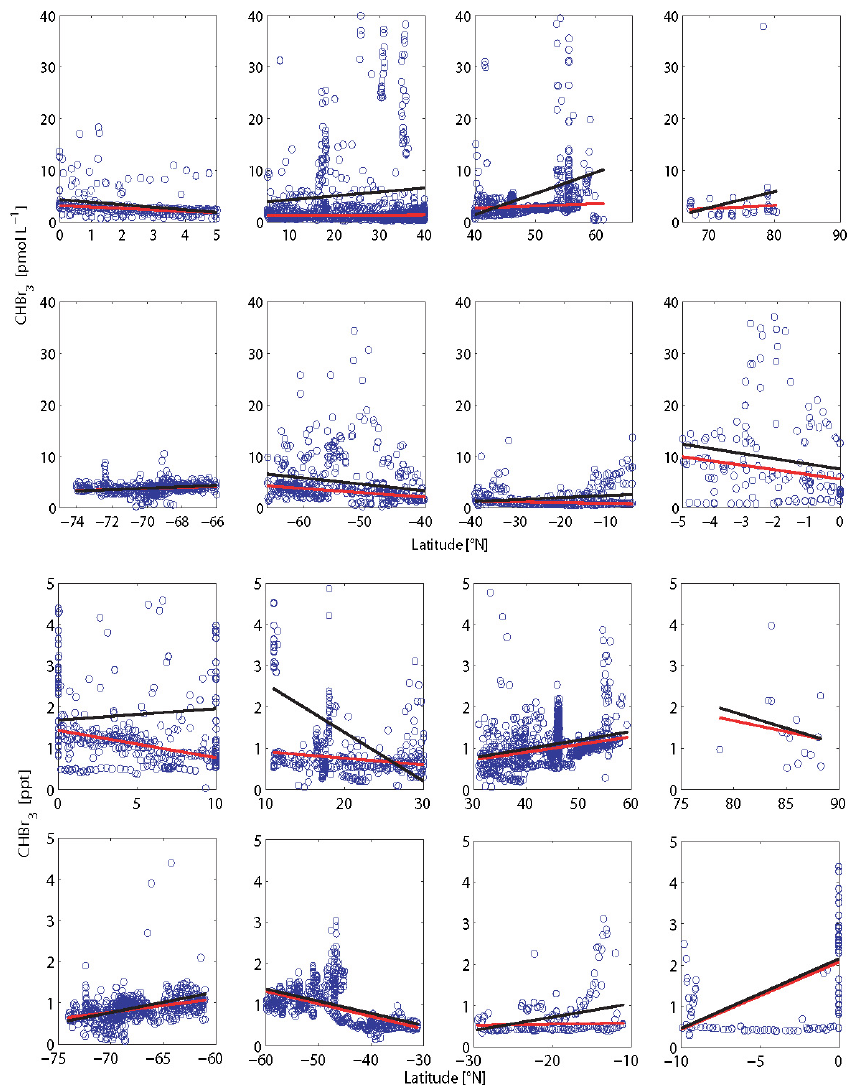
Fig. 2. Latitudinal distribution of open ocean water (a) (pmolL − 1 ) and atmosphere (b) (ppt) bromoform concentrations (blue circles) clas- sified in eight different latitudinal bands. The robust fit (RF) (red line) and ordinary least squares (OLS) (black line) regression analyses are